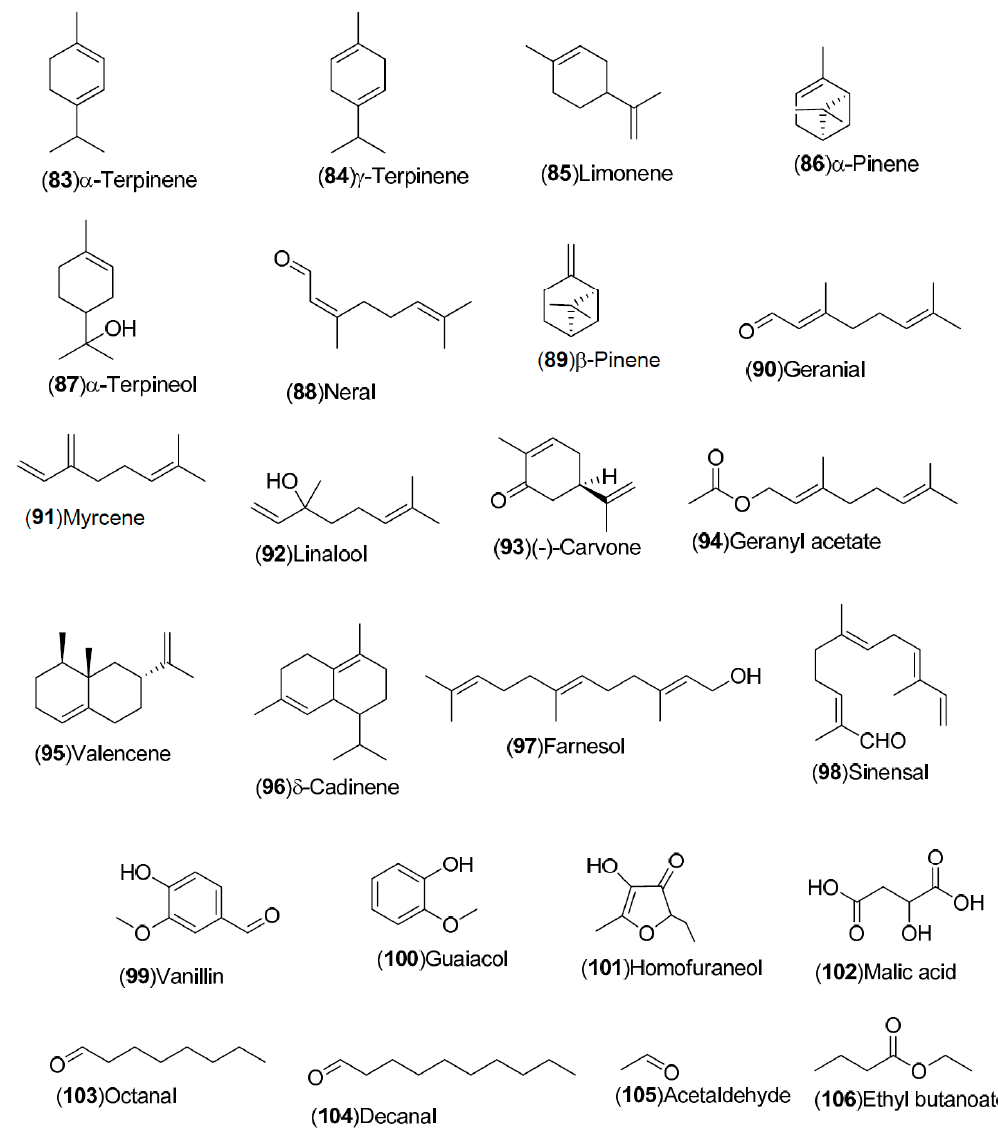
Figure 9. Figure 9. Cont. Figure 9. Cont.